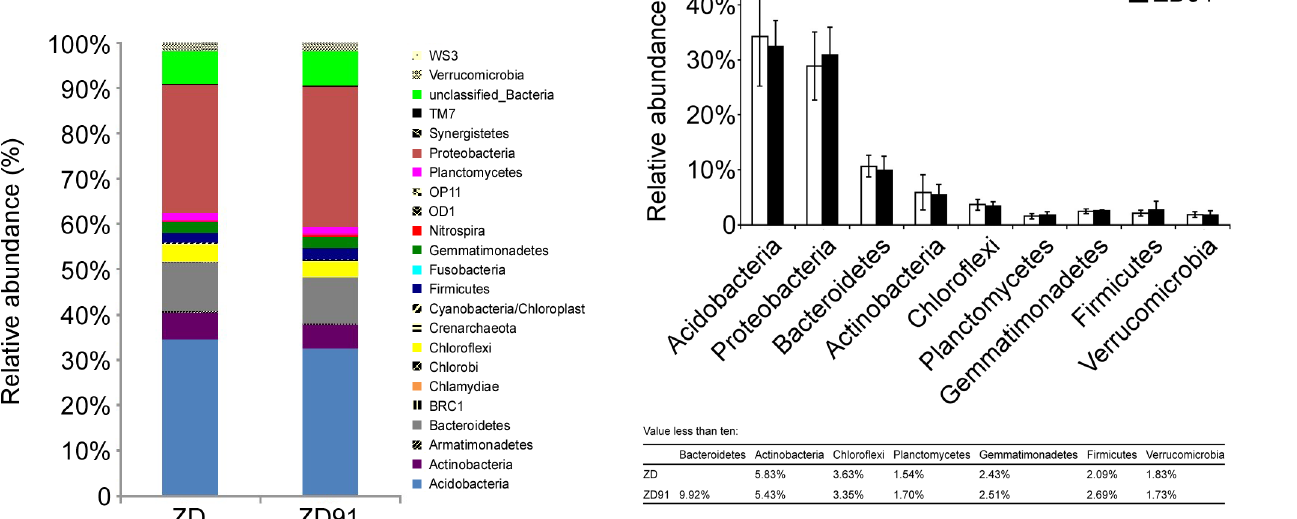
Figure 3. Relative abundance of main phyla in the rhizosphere of soybean cultivars. Error bars indicate standard errors. The p -values of the nine groups of bacteria, in order, were 0.734, 0.633, 0.662, 0.834, 0.687, 0.690, 0.751, 0.493, and 0.840 when testing for differences between cultivar ZD and transgenic cultivar ZD91.